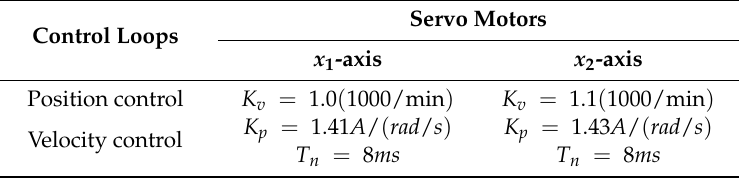
Table 8. Servo parameters of x 1 -axis and x 2 -axis